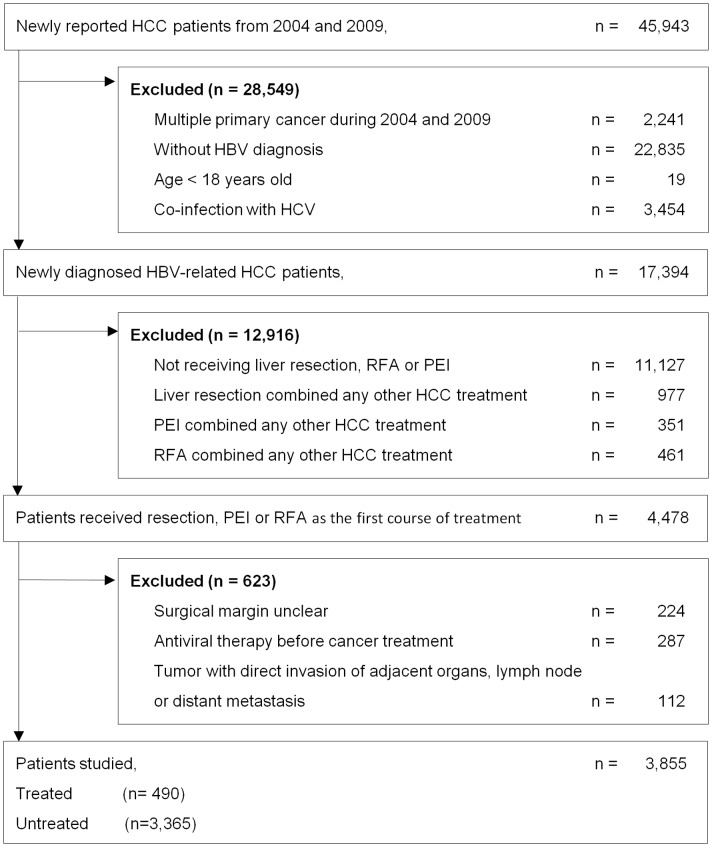
Study flow diagram.